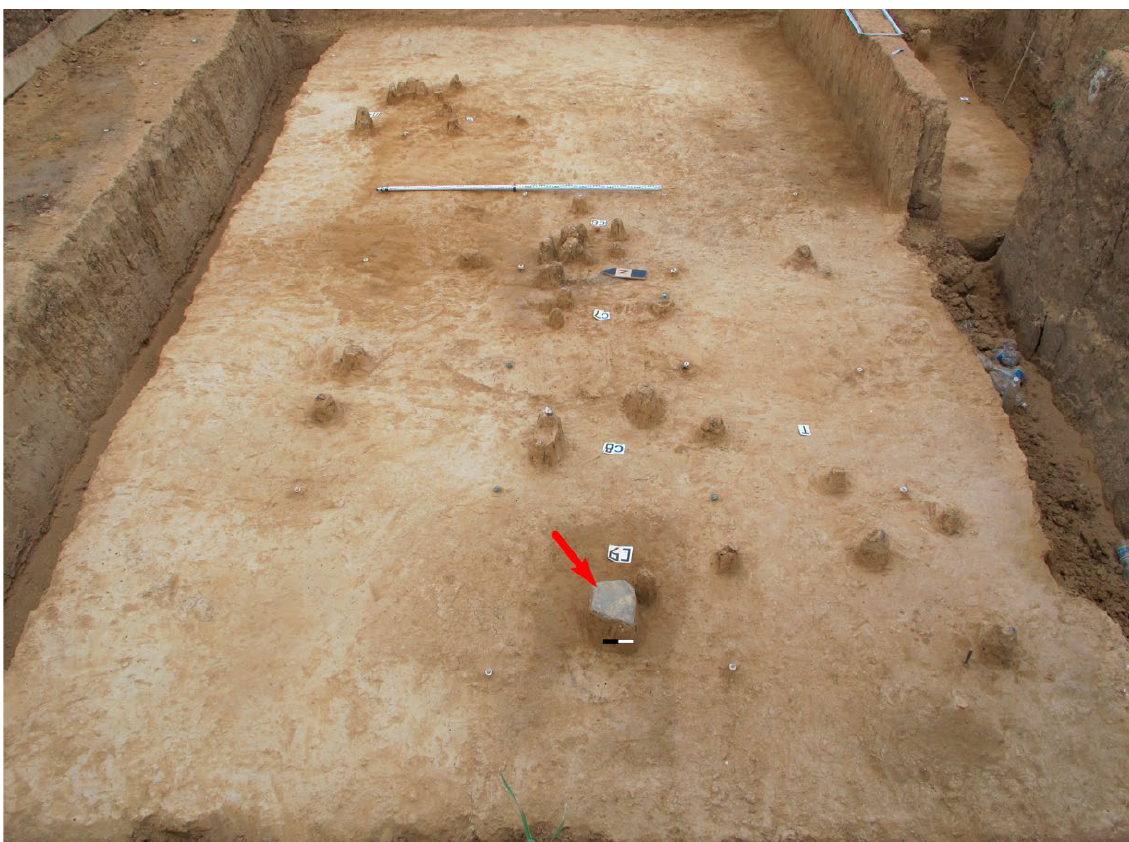
Figure 2. Kamennaya Balka II site. Location of the studied slab in the lower layer (scale bar = 10 с